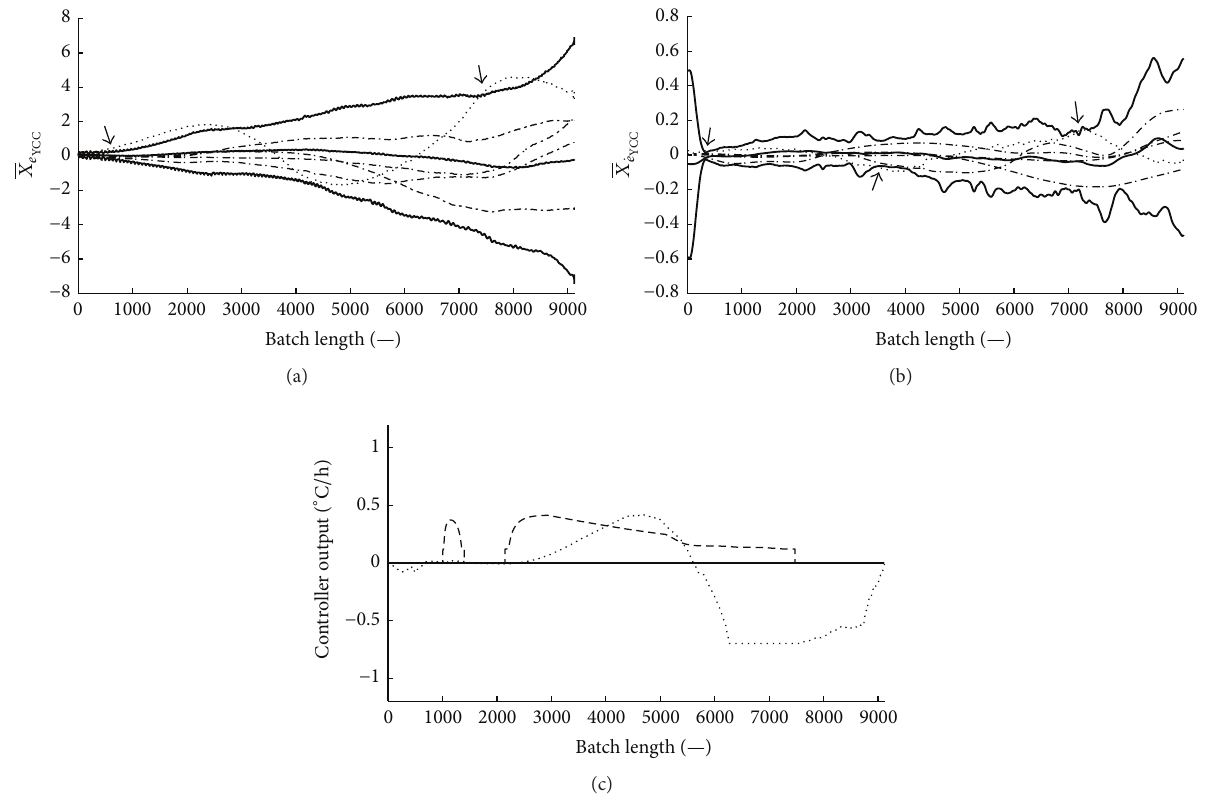
Figure 6: Online control charts for control error 𝑒 (a) and its derivative ̇𝑒 (b). The solid bold lines (-) are the statistical values of the YCC YCC upper control limit, mean, and lower control limit. The dotted ( ⋅⋅⋅ ) curve is the trajectory that belongs to the nontuned fuzzy controller. The arrows mark where it leaves the statistical corridor. The residual lines (— ⋅ —) stay clearly within the control limits and show the error trajectories resulting from the genetic tuned fuzzy controller. Graph (c) shows the output of the nontuned fuzzy controller ( ⋅⋅⋅ ) in comparison to the output of the genetic tuned controller (- -